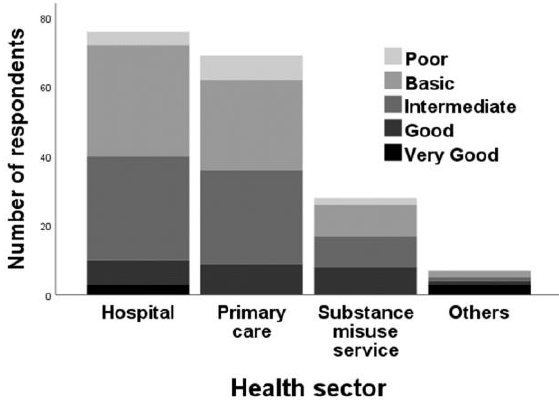
Figure 4. Self-reported level of knowledge on novel psychoactive substances (NPS) among different health sectors.